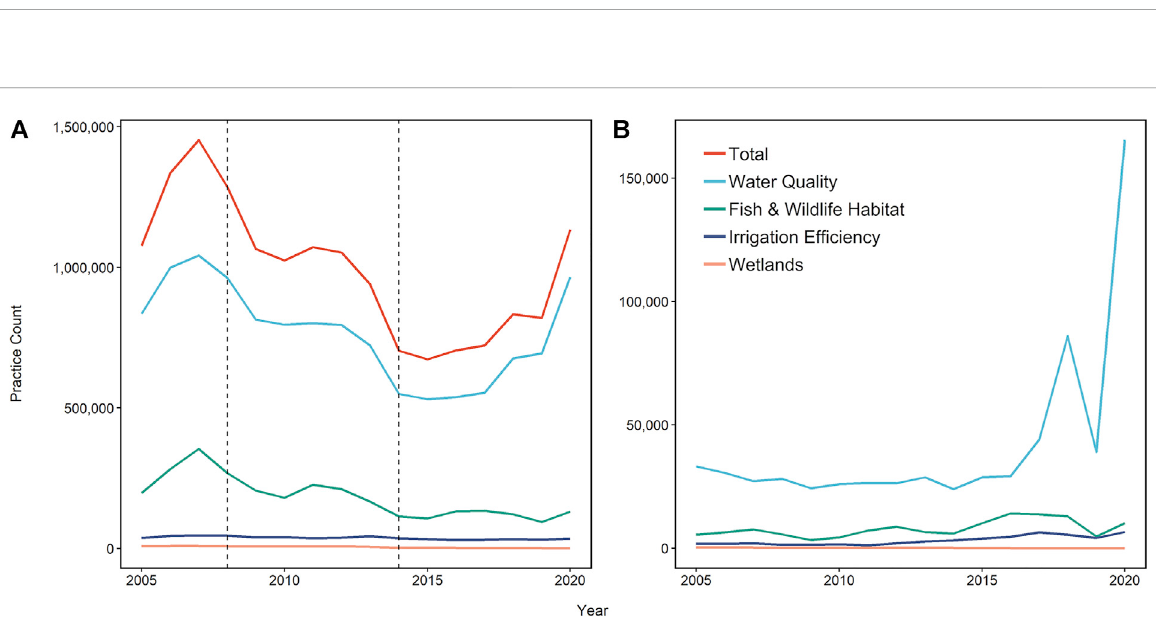
FIGURE 2 Changes in the number of projects (i.e., practice counts) in USDA RCA programs over time. Panel (A) gives the practice count by year for all practices combined (red line) and for each performance measure individually. Dashed vertical lines denote the 2008 and 2014 USDA Farm Bills, legislative events that restructured RCA payment schemes. Panel (B) gives the same data for the state of